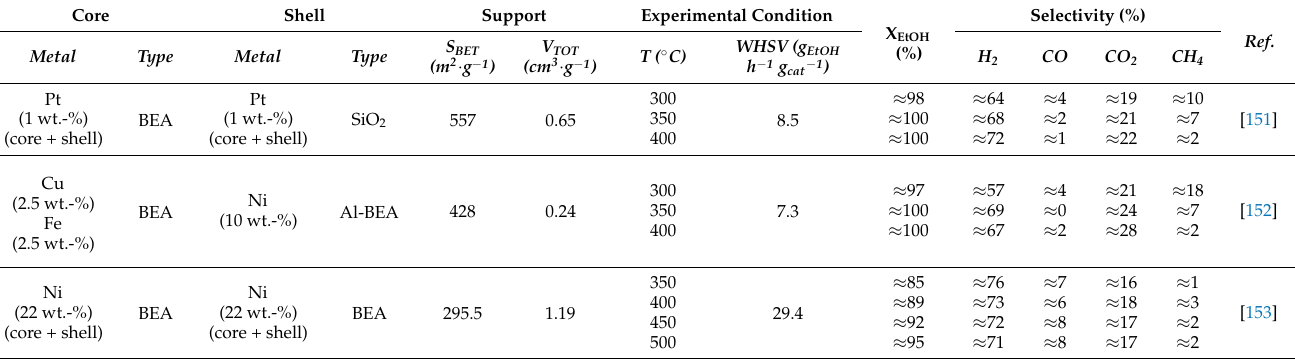
Table 6. Core–shell support for the various types of metal catalysts for the ESR reaction.